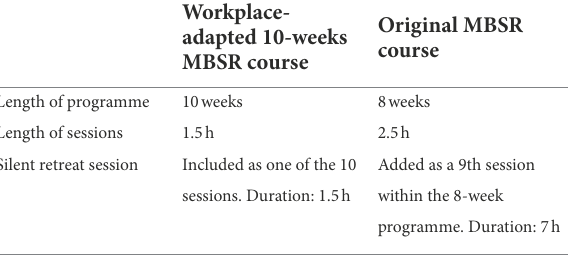
TABLE 2 Differences between the original and workplace-adapted MBSR